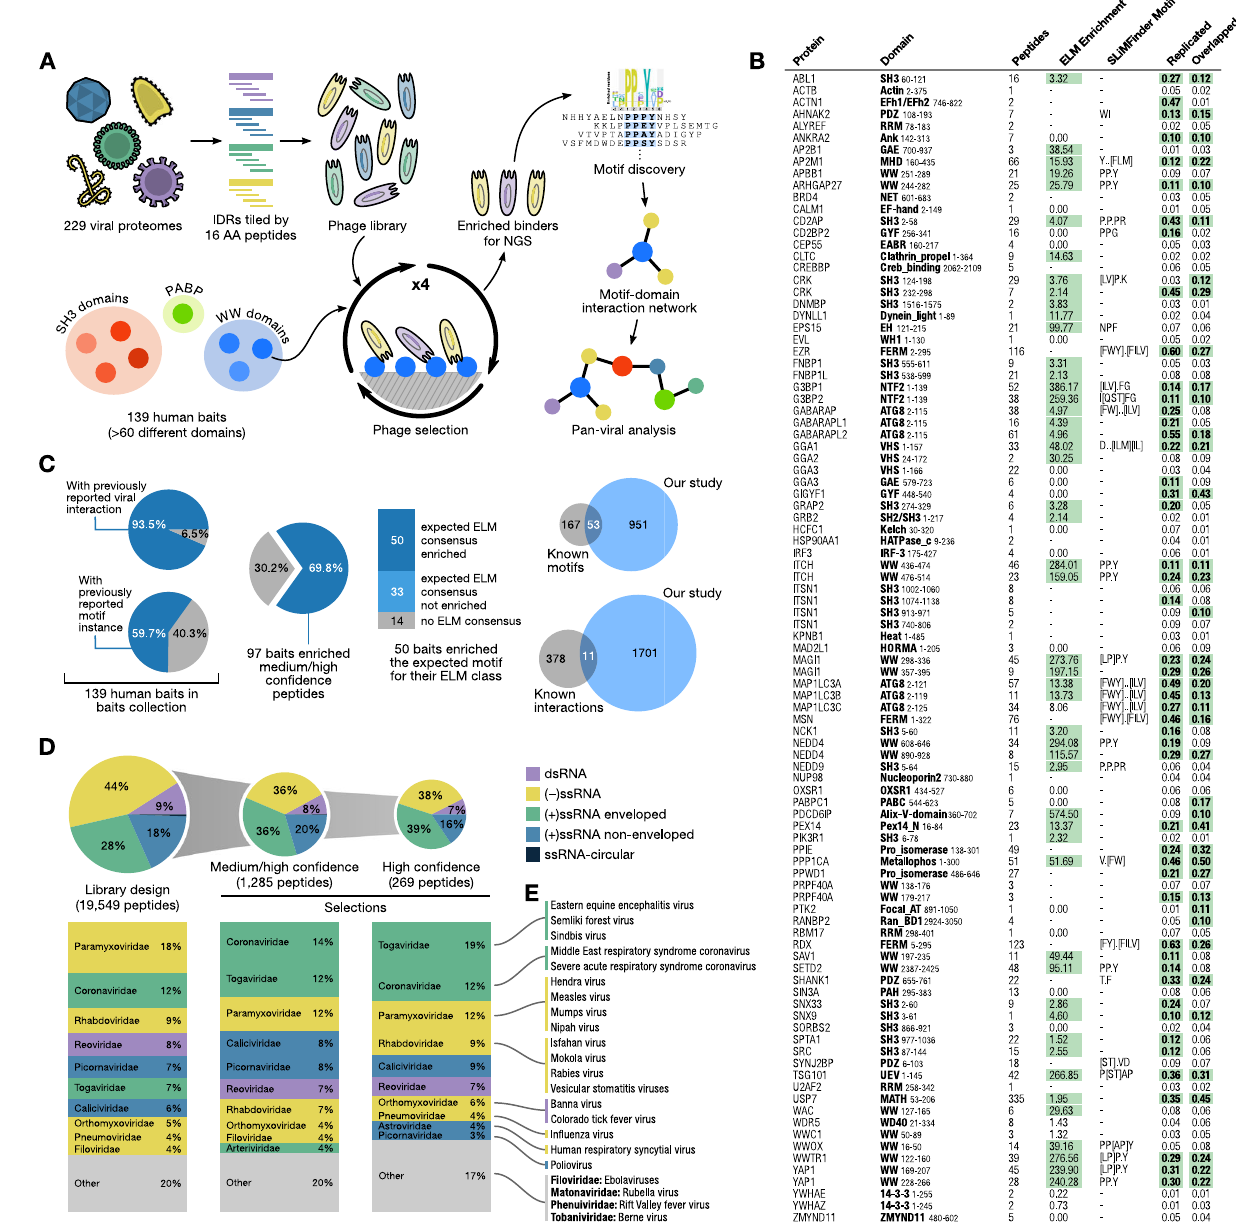
Fig.1|OverviewoftheRiboVDlibrarydesignandselectionoutcome.A General work fl ow of the ProP-PDselection processand the dataanalysis. B Overviewofthe RiboVD selection results showing for each bait the number of enriched medium/ highcon fi dencepeptides,theenrichmentofpeptideswithsequencesmatchingthe consensus motif reported in ELM database, the generated motifs based on the enriched peptides (SLiMFinder Motif), and the quality of the selection results. “ Replicated ” representstheproportionofallpeptidesfoundinselectionsthatwere replicated in independent selections with the same bait while “ Overlapped ” is the proportion of all peptides that had overlapping peptides among all replicates for each bait. Green highlight indicates high quality of results. C Overview of the bait collection usedinthis studyand the comparison of the selection results incontext of previously known information. Left, percentage of baits used with previously known viral interactors (130 out of 139, Supplementary data 2) or previously